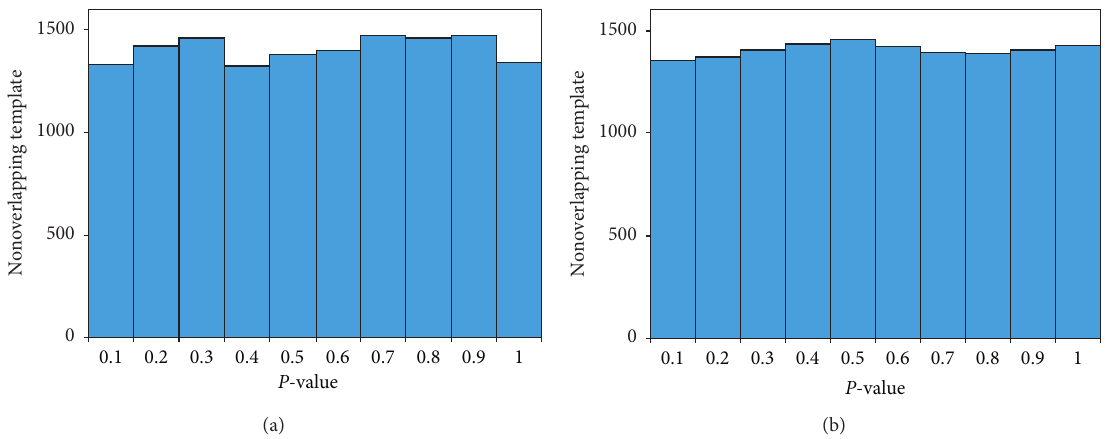
Figure 14: Probability distribution of P − value for the nonoverlapping template. (a) Case 1 system. (b) Case 2 system.